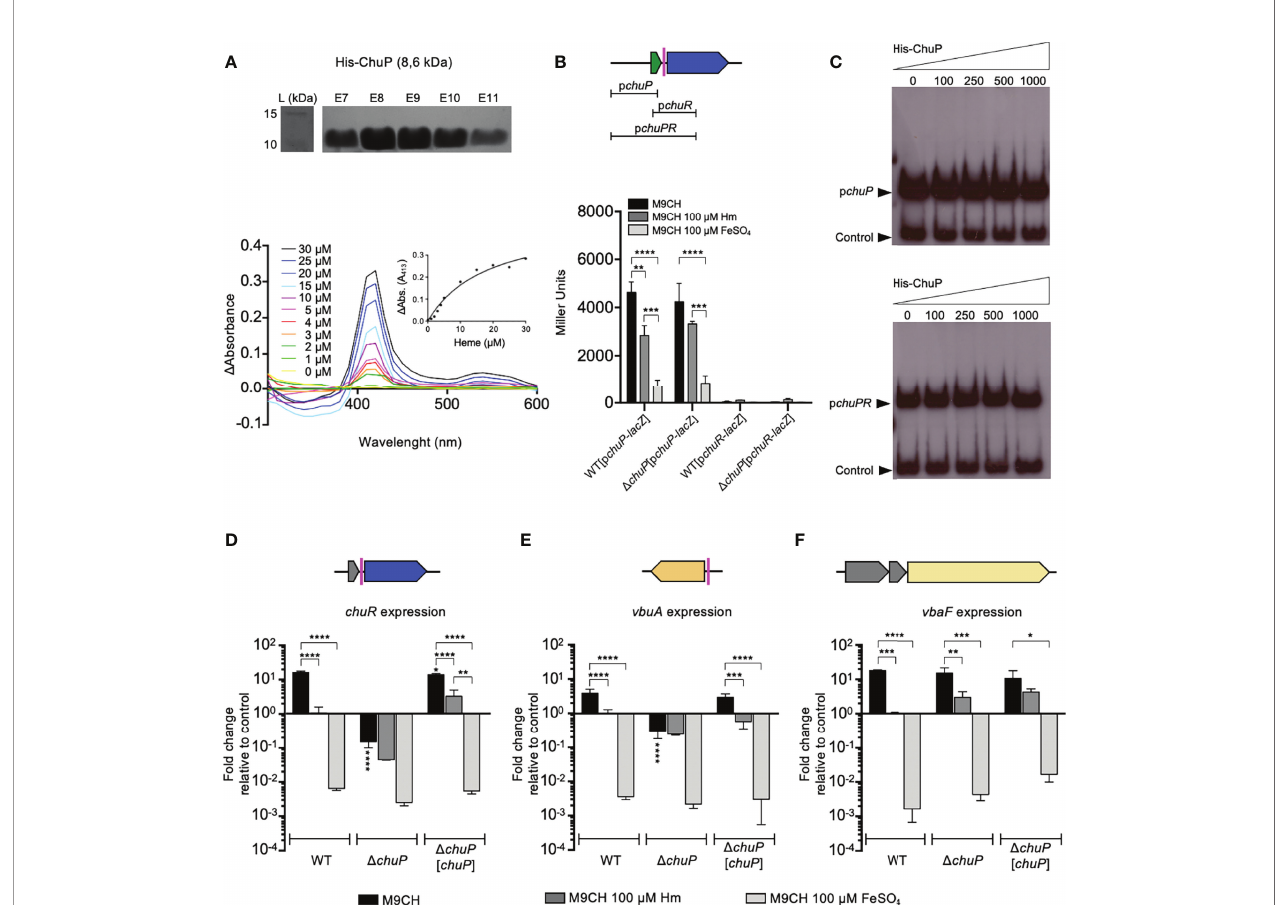
FIGURE 4 | ChuP is a heme-binding regulatory protein that controls chuR and vbuA expression at a post-transcriptional level. (A) ChuP binds heme. The His-ChuP protein was puri fi ed (top) and incubated (10 m M protein) with the indicated concentrations of Hm (bottom). The absorption spectra were measured from 300 nm to 600 nm on a SpectraMax i3 MiniMax Imaging Cytometer. The changes at 413 nm were used to calculate the ChuP-Hm af fi nity (insert). Data are shown as differential absorption spectra: the difference of values obtained from the sample cuvette (His-ChuP and Hm) against the reference cuvette (Hm). Data are from a single experiment of three independent replicates. L, protein ladder; E7 to E11, eluted fractions of puri fi ed ChuP. (B) ChuP does not regulate the promoter of the chu operon. The scheme (top) indicates the regions used for b -galactosidase or EMSA assays. b -galactosidase assays were performed from the WT and D chuP strains harboring chuP-lacZ and chuR - lacZ fusions grown in M9CH in the indicated conditions of iron availability. Data are from three biological replicates. **p < 0.01; ***p < 0.001; ****p < 0.0001. When not shown, n.s. (not signi fi cant). Two-way ANOVA followed by Dunnett ’ s multiple-comparison test. (C) ChuP does not bind to DNA probes covering from chuP to chuR . The indicated concentrations of His- ChuP were used in EMSA assays with the chu indicated probes. In both cases, the promoter region of CV_2599 (control) was used as an in-reaction unspeci fi c negative control. (D-F) chuR and vbuA but not vbaF have HPRE sequences and are regulated by ChuP. The predicted HPREs are indicated as colored bars in the gene maps. Expression was evaluated by RT-qPCR. cDNA was reverse transcribed from RNA obtained from the WT, D chuP , and D chuP [ chuP ] strains grown in M9CH, and either untreated or treated with 100 m M Hm or 100 m M FeSO 4 . Expression of chuR , vbuA , and vbaF is shown as the fold change relative to the control condition (WT in M9CH